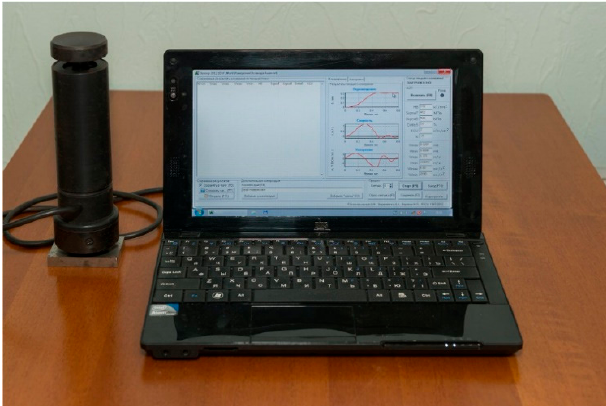
Figure 5. The device for impact cone indentation.